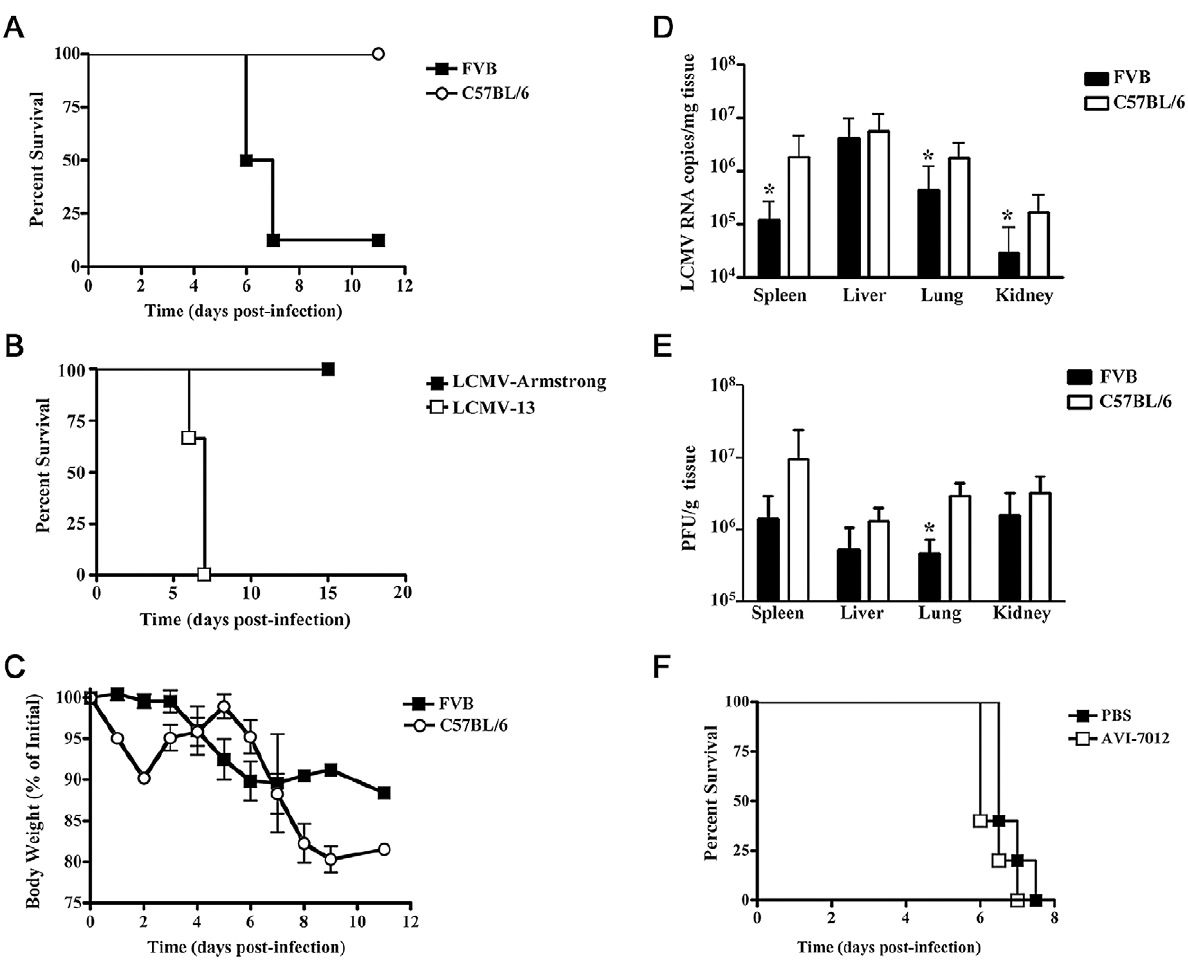
Figure 3. FVB mice develop an acute lethal disease after LCMV-13 infection independent of reduced viral titers in tissues. FVB or C57BL/6 mice were infected with 1–2 6 10 6 p.f.u. and monitored for up to 11-days post-infection for development of disease signs or death. Animals were humanely killed upon development of severe disease. A) Survival curves of FVB and C57BL/6 mice (n=11). B) Survival curves of FVB mice infected with LCMV-13 and LCMV-Arm (n=3 mice) C) Weight change of FVB (n=8) and C57BL/6 (n=10) mice starting from pre-infection levels. Results are presented as a mean percentage of initial weight + / 2 standard deviation. D) Viral RNA in tissues of FVB (n=13) and C57BL/6 (n=15) mice infected with LCMV-13. Levels of viral RNA in indicated tissues at time of death were quantified by qRT-PCR for LCMV RNA. Results are presented as mean + / 2 standard deviation (*, p , 0.05. One-way Anova). E) Viral burden as assessed by plaque assay. Infectious virus was quantified day 7 post- infection for all mice (n=5). Results are presented as mean + / 2 standard deviation (*, p , 0.05. t-test). F) FVB mice treated with anti-arenavirus antisense did not exhibit increased survival to LCMV infection compared to PBS treated animals (n=5). (Figure 7d), which again suggests viral replication alone is not causing hemorrhagic disease.